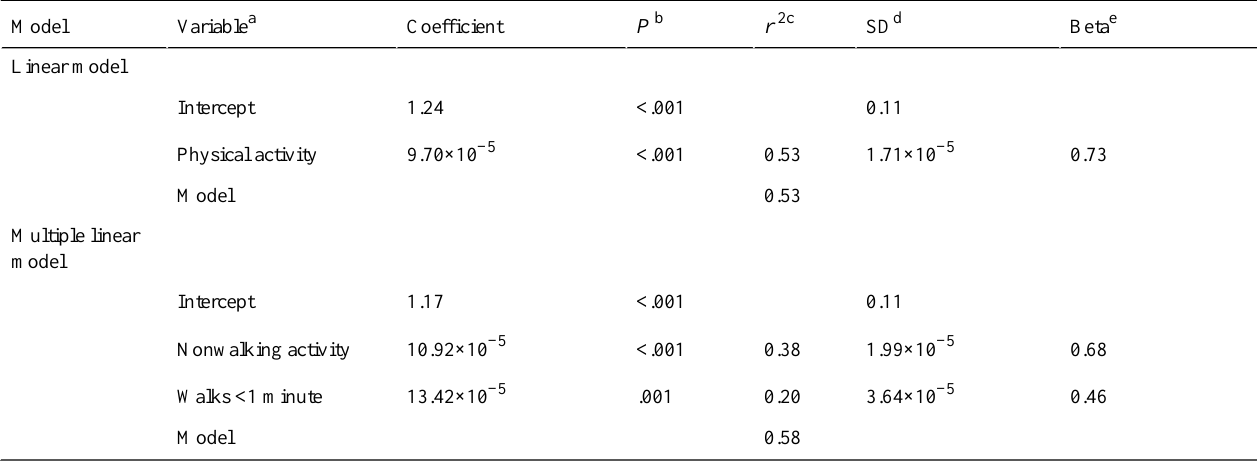
Table 3. Two prediction equations of physical activity level from accelerometer counts.